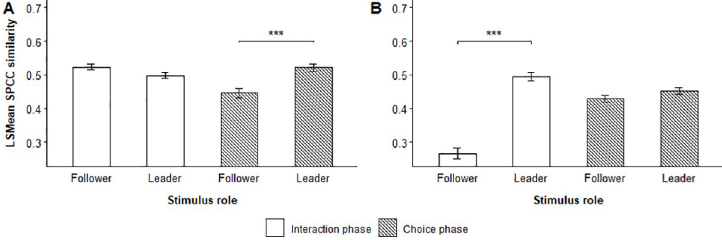
Fig 5. Effect of chosen vocal role on stimulus-response similarity. LSMean ( ± SE) spectrographic cross-correlation (SPCC) similarity between stimulus calls and focal flock responses emitted during the interaction and choice phase of (A) male-male trials and (B) male-female trials. The figure shows the difference between leaders and followers that were chosen by focal flocks. Significant selected pairwise comparisons are indicated with asterisks.